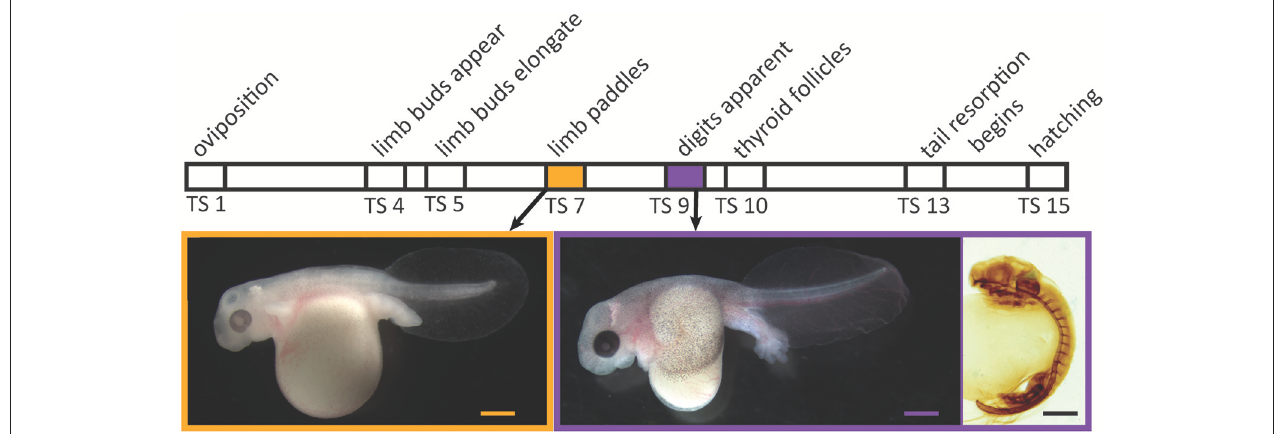
FIGURE 1 | Relative timing of several developmental events during embryogenesis in Eleutherodactylus coqui . Images depict live TS stage 7 (Left) and stage 9 (Middle) embryos removed from overlying egg membranes, and a TS stage 9 embryo (Right) stained for type II collagen, which reveals the cartilaginous skeleton and notochord. Scale bars,